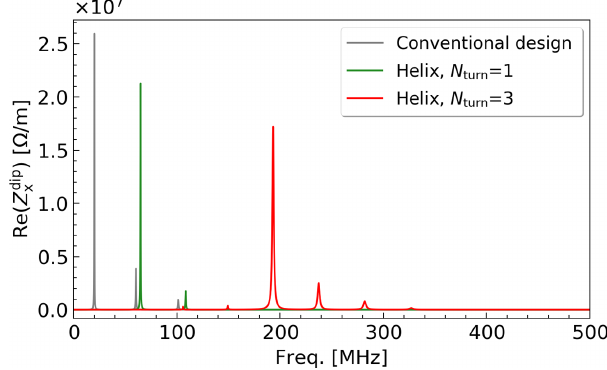
FIG. 12. Real part of the horizontal dipolar transverse imped- ance of the helix with 1 and 3 turns, a symmetric vacuum gap and L ¼ 44 mm, in comparison with the initial design of the overlap conventional beam screen (eigenmode